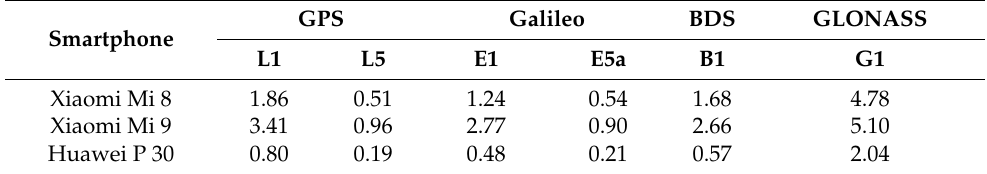
Figure 4. Histograms of the smartphone L1/E1/B1/G1 code residuals computed as the observations that were double differenced in a time domain. One should note that the GLONASS panel has different axis limits of code residuals when compared to the other panels. We also note an existence of outliers that are included in the outmost bins of code residuals. Table 2. STD of code noise normalized to undifferenced observations in the units of